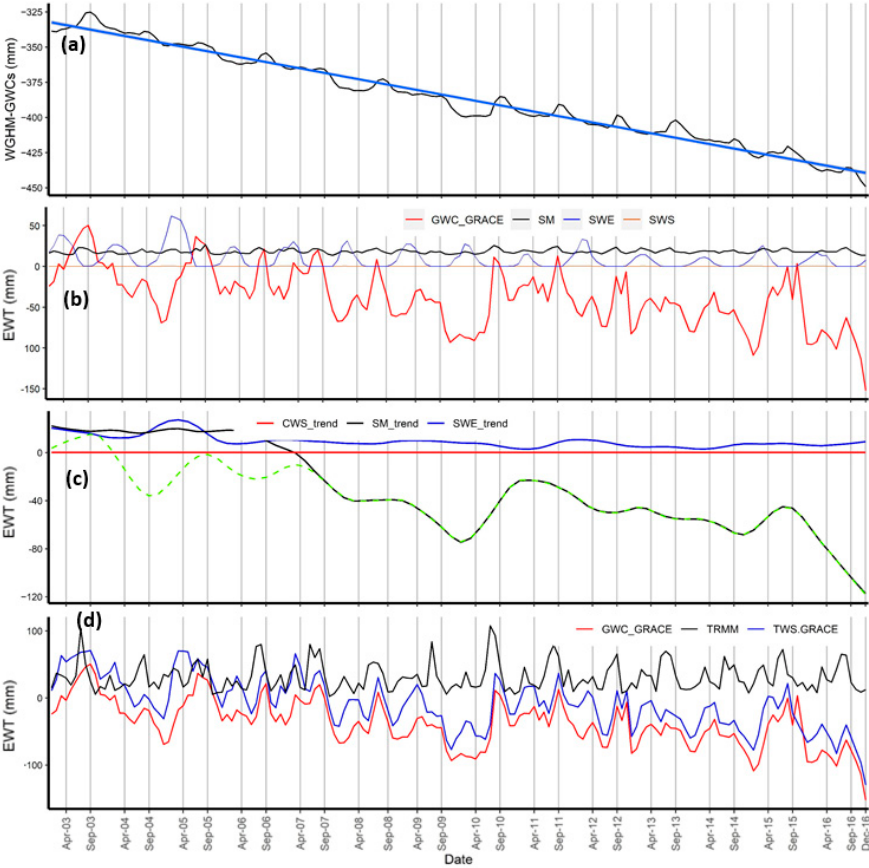
Figure 5. ( a ) Groundwater storage changes in WGHM (black line indicates the groundwater storage of WGHM and blue line indicates the fitted regression line); ( b ) changes and ( c ) trends of GWC, soil moisture (SM), canopy water storage (SWS), and snow water equivalent (SWE); ( d ) comparison of monthly time series of the GRACE-based GWC and TWS values and TRMM precipitation data in IRB .